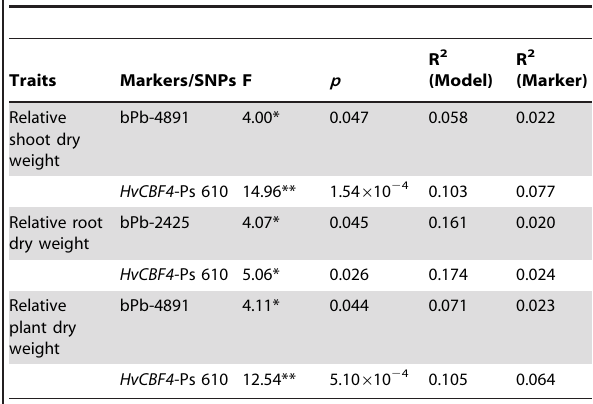
Table 3. The results of DArT markers on chromosome 5 and SNPs of HvCBF genes associated with relative dry weight of Tibetan barley.